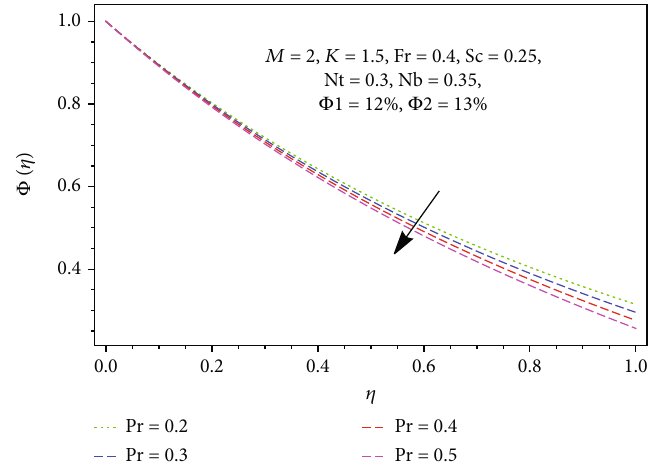
Figure 12: Impact of Prandtl number Pr on the concentration pro fi le ϕ ð η Þ .